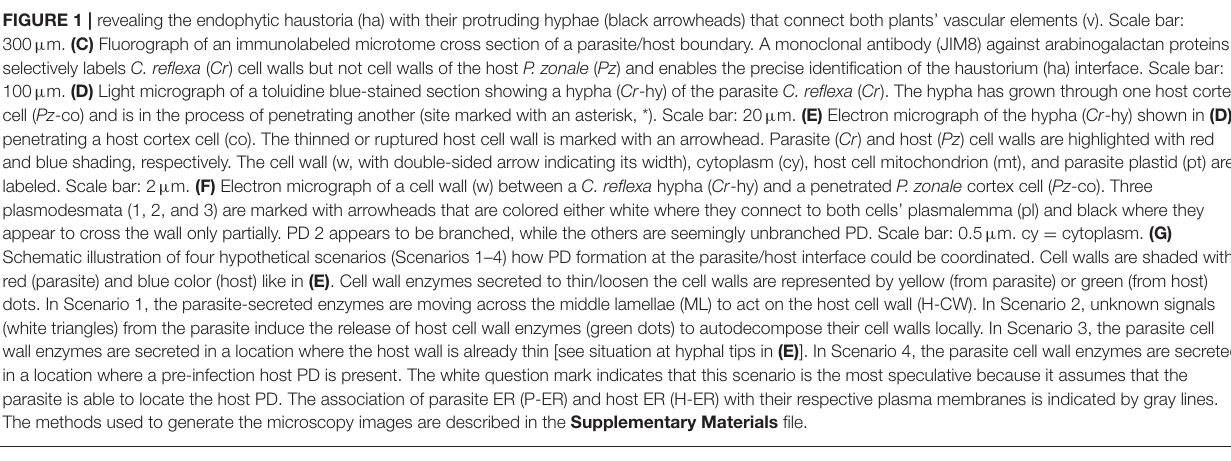
FIGURE 1 | revealing the endophytic haustoria (ha) with their protruding hyphae (black arrowheads) that connect both plants’ vascular elements (v). Scale bar: 300 µ m. (C) Fluorograph of an immunolabeled microtome cross section of a parasite/host boundary. A monoclonal antibody (JIM8) against arabinogalactan proteins selectively labels C. reflexa ( Cr ) cell walls but not cell walls of the host P. zonale ( Pz ) and enables the precise identification of the haustorium (ha) interface. Scale bar: 100 µ m. (D) Light micrograph of a toluidine blue-stained section showing a hypha ( Cr -hy) of the parasite C. reflexa ( Cr ). The hypha has grown through one host cortex cell ( Pz -co) and is in the process of penetrating another (site marked with an asterisk, *). Scale bar: 20 µ m. (E) Electron micrograph of the hypha ( Cr -hy) shown in (D) penetrating a host cortex cell (co). The thinned or ruptured host cell wall is marked with an arrowhead. Parasite ( Cr ) and host ( Pz ) cell walls are highlighted with red and blue shading, respectively. The cell wall (w, with double-sided arrow indicating its width), cytoplasm (cy), host cell mitochondrion (mt), and parasite plastid (pt) are labeled. Scale bar: 2 µ m. (F) Electron micrograph of a cell wall (w) between a C. reflexa hypha ( Cr -hy) and a penetrated P. zonale cortex cell ( Pz -co). Three plasmodesmata (1, 2, and 3) are marked with arrowheads that are colored either white where they connect to both cells’ plasmalemma (pl) and black where they appear to cross the wall only partially. PD 2 appears to be branched, while the others are seemingly unbranched PD. Scale bar: 0.5 µ m. cy = cytoplasm. (G) Schematic illustration of four hypothetical scenarios (Scenarios 1–4) how PD formation at the parasite/host interface could be coordinated. Cell walls are shaded with red (parasite) and blue color (host) like in (E) . Cell wall enzymes secreted to thin/loosen the cell walls are represented by yellow (from parasite) or green (from host) dots. In Scenario 1, the parasite-secreted enzymes are moving across the middle lamellae (ML) to act on the host cell wall (H-CW). In Scenario 2, unknown signals (white triangles) from the parasite induce the release of host cell wall enzymes (green dots) to autodecompose their cell walls locally. In Scenario 3, the parasite cell wall enzymes are secreted in a location where the host wall is already thin [see situation at hyphal tips in (E) ]. In Scenario 4, the parasite cell wall enzymes are secreted in a location where a pre-infection host PD is present. The white question mark indicates that this scenario is the most speculative because it assumes that the parasite is able to locate the host PD. The association of parasite ER (P-ER) and host ER (H-ER) with their respective plasma membranes is indicated by gray lines. The methods used to generate the microscopy images are described in the Supplementary Materials